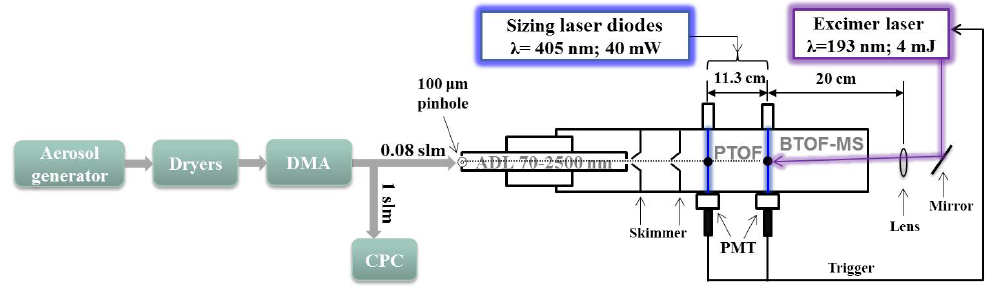
Figure 1. Schematic of the LAAPTOF instrument and the experimental setup for measuring standard samples (method A), e.g. PSL, NH 4 NO 3 , and K 2 SO 4 particles, which were generated from a nebulizer, passed through two dryers, were size-selected by a differential mobility analyser (DMA), and were then measured by